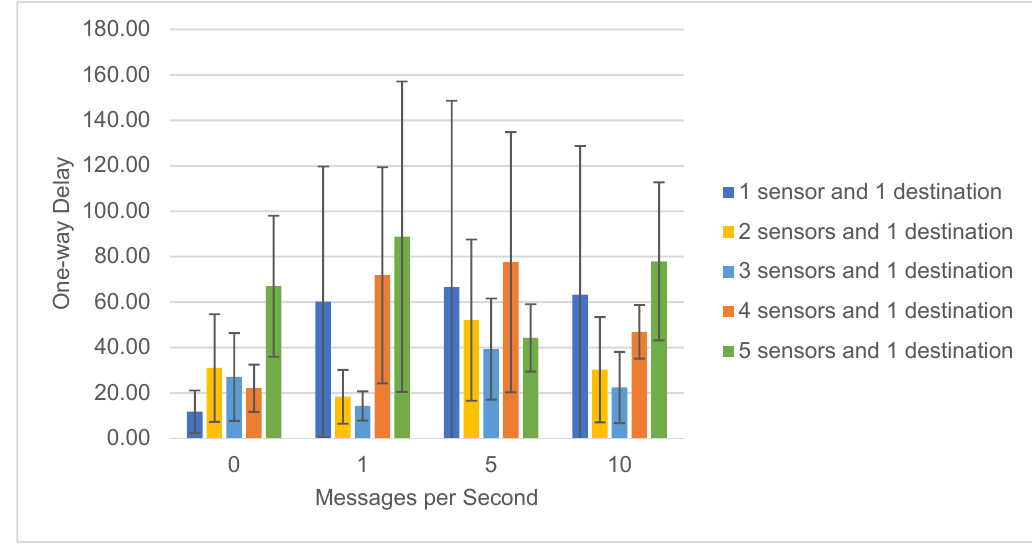
Figure 17. One-way delivery delay (s) as a function of the number of network nodes.